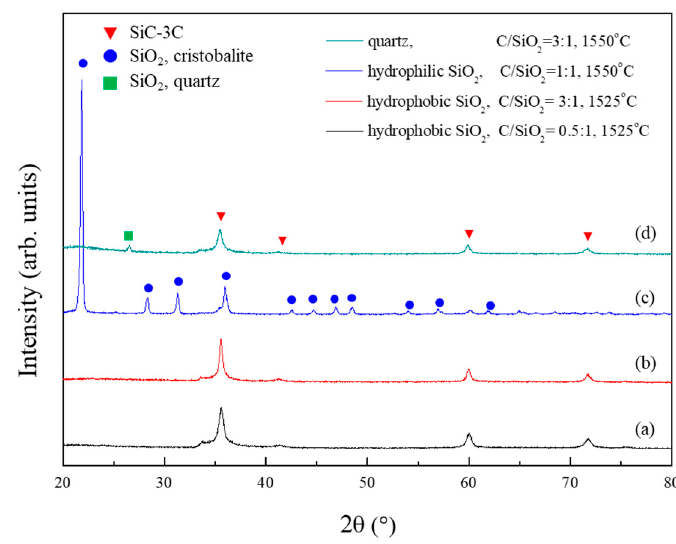
Figure 6. XRD patterns of the powder samples synthesized from ( a ) the hydrophobic silica aerogel (C / SiO 2 ratio of 0.5), ( b ) the hydrophobic silica aerogel (C / SiO 2 ratio of 3), ( c ) the hydrophilic silica aerogel (C / SiO 2 ratio of 1), and ( d ) the quartz (C / SiO 2 ratio of 3).